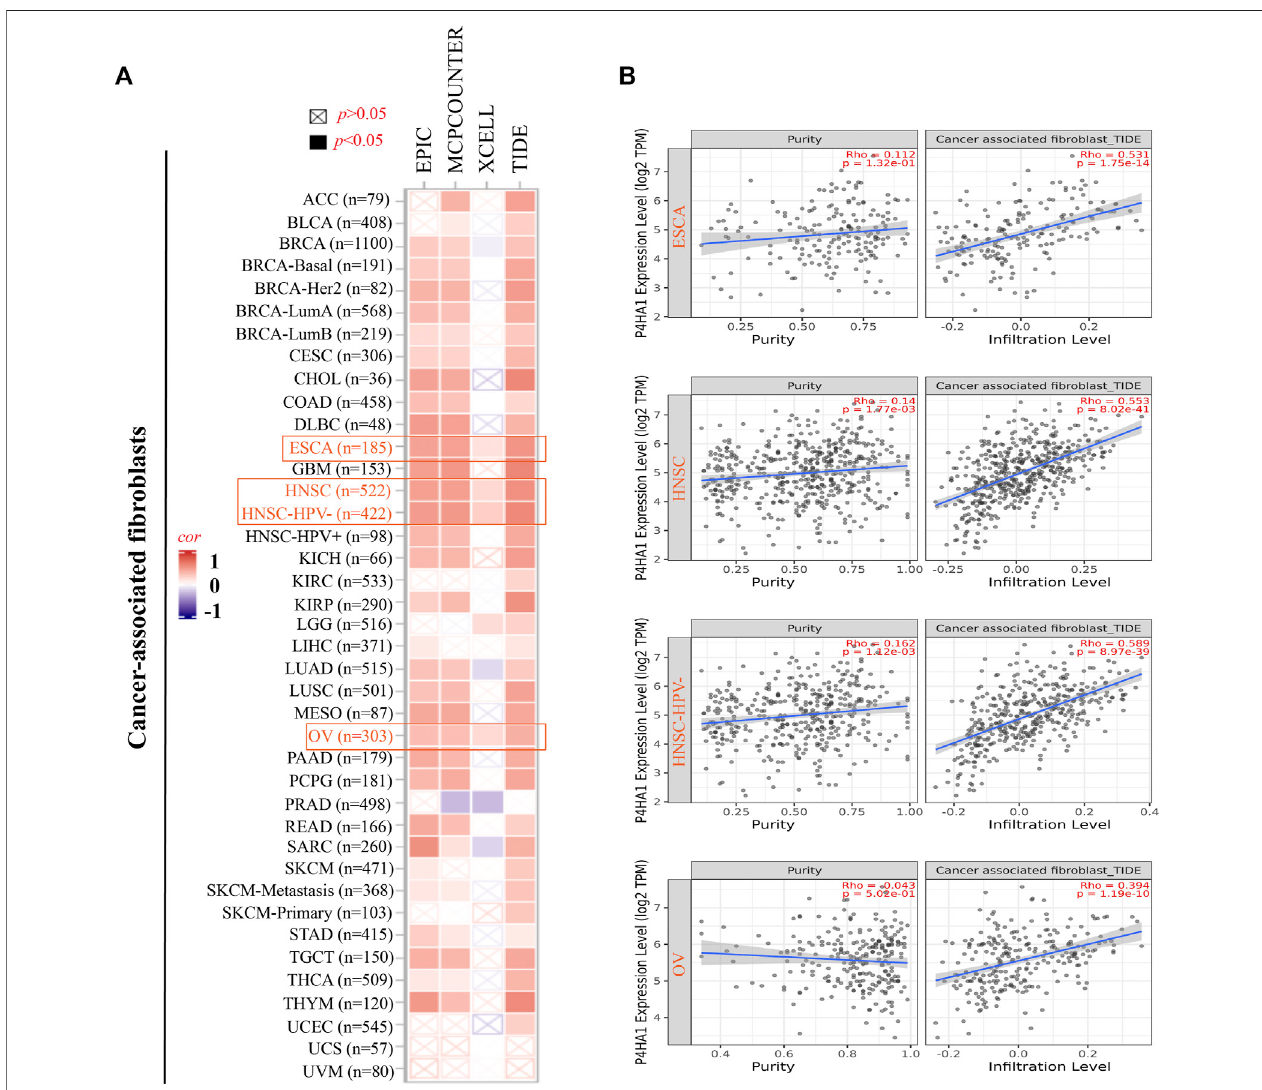
FIGURE 4 | Correlation analysis between the P4HA1 expression level and immune in fi ltration of cancer-associated fi broblasts (CAFs). (A,B) Different algorithms (EPIC, MCPCOUNTER, XCELL, and TIDE) were applied to con fi rm the potential correlation between the expression level of P4HA1 and the in fi ltration level of CAFs across distinct types of tumors in